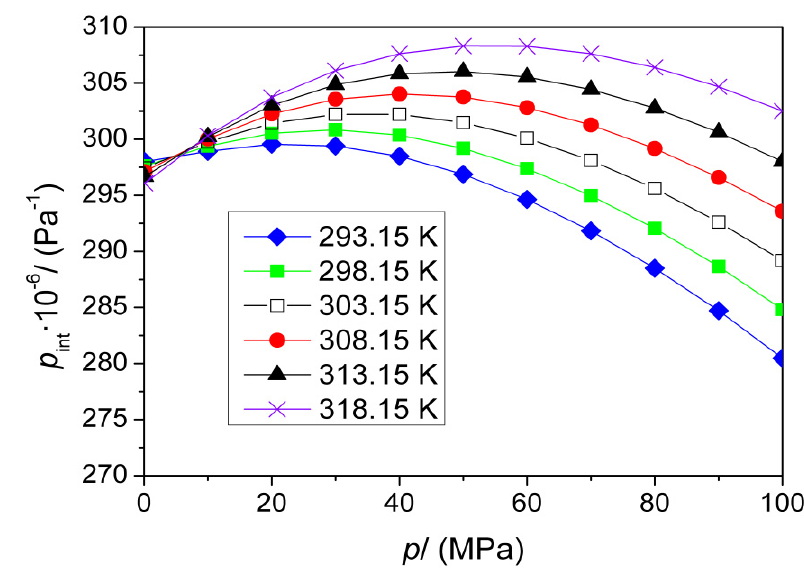
Figure 16. The pressure dependence of internal pressure of 1-butanol obtained in this work.